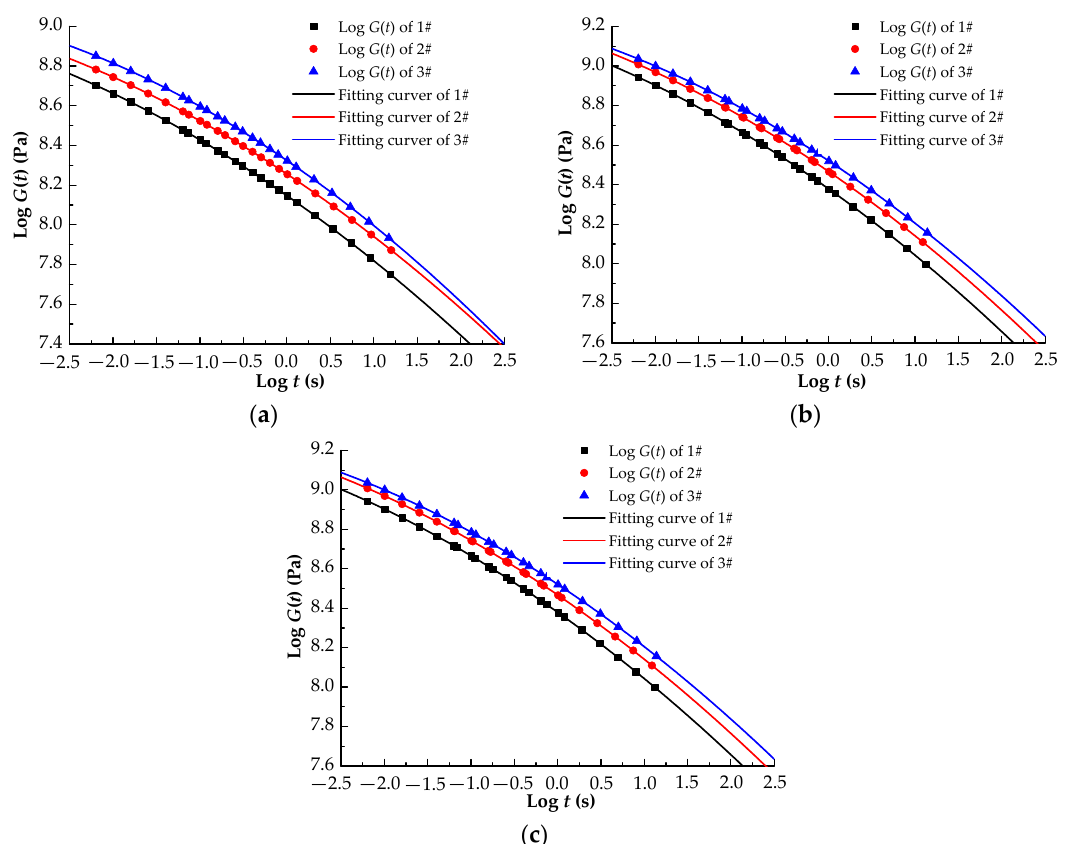
Figure 6. Master curves of relaxation modulus G ( t ) for di ff erent aging levels. ( a ) RTFOT; ( b ) 1PAV; ( c ) 2PAV. Table 5. Fitting parameters of master curves of relaxation modulus for the three aging